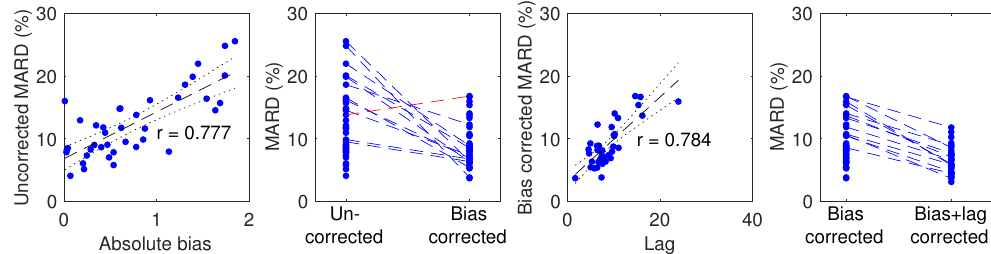
Figure 5. Effect of bias and lag correction. Left: Uncorrected MARD plotted against absolute bias. Middle left: MARD changes as a result of bias correction with individual participant tracing. Points belonging to the 12 participants whose MARD changed by more than 3 percentage points are connected by a dotted line (blue when MARD is reduced; red when MARD is increased). Middle right: Bias corrected MARD plotted against lag. Right: MARD changes as a result of lag correction. Regression lines are plotted in dashed black and 95% CIs in dotted